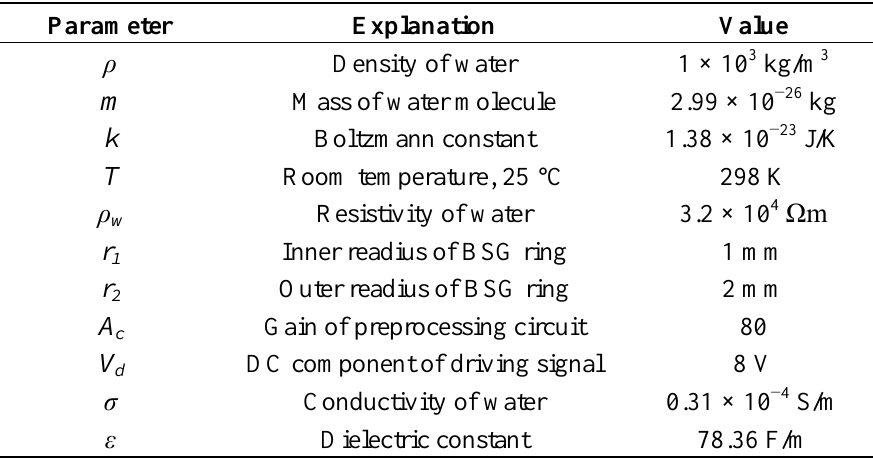
Table 1. Parameters used in the